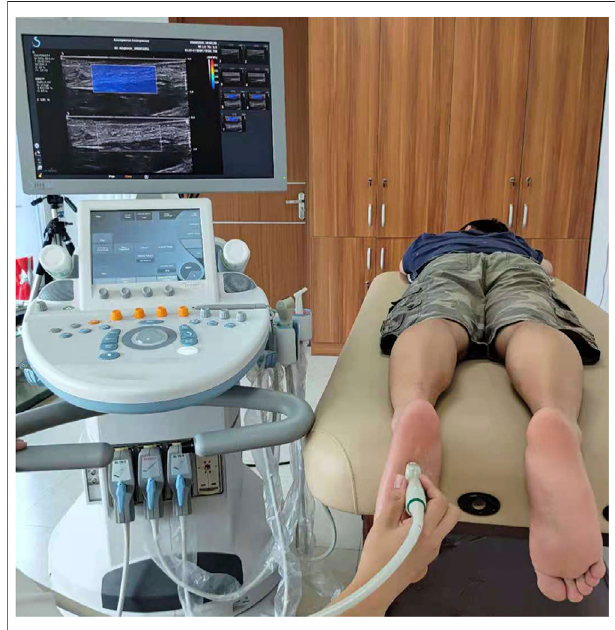
FIGURE 1 | The experimental device and the position of the